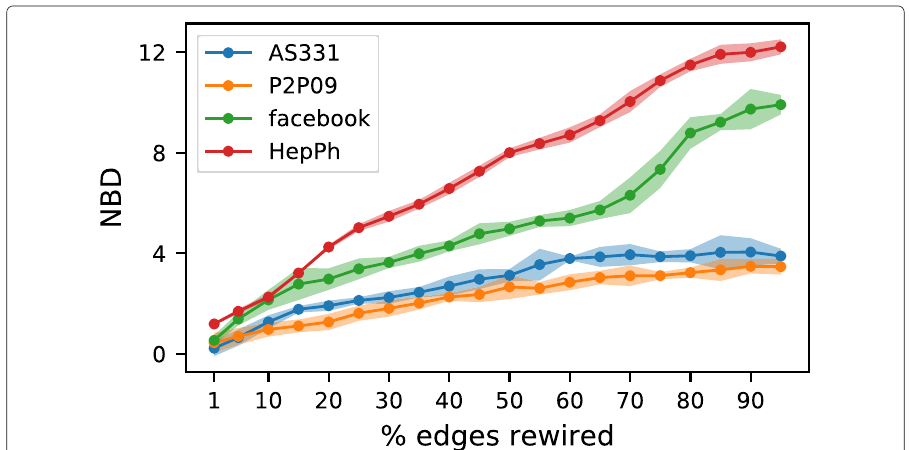
Fig. 11 NBD in the presence of noise. For each graph AS331 , P2P09 , facebook , HepPh we compute 10 rewired versions using degree-preserving randomization, for increasing percentage of edges rewired. We show the average NBD between the original graph and the rewired versions; shaded regions indicate standard deviation. As expected, NBD is an increasing function the percentage of rewired edges. This implies that NBD is detecting graph structural features that are not determined by degree